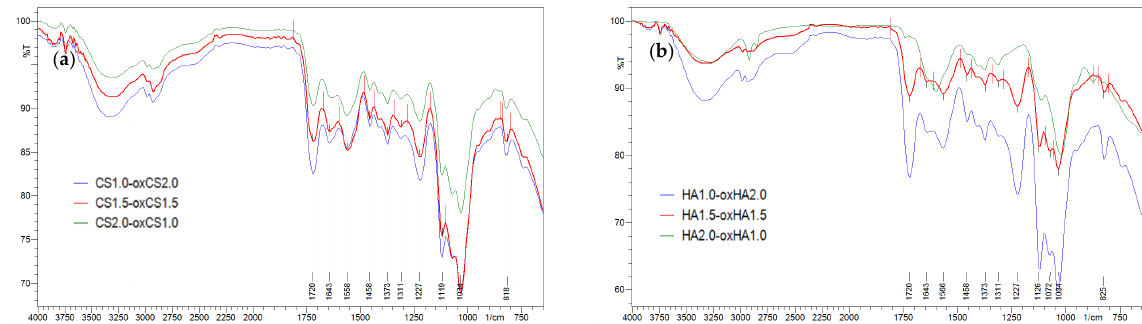
Figure 6. FT-IR spectra of CS-oxCS ( a ) and CS-oxHA ( b ) hydrogels.